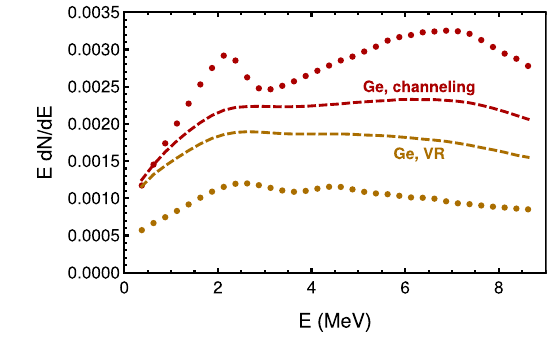
Fig. 6 Simulated radiation spectral intensities in case of channeling (red) and VR (yellow) orientations for the bent Si (left) and Ge (right) crystals, respectively. The bending angles were 750 µ rad for Si and